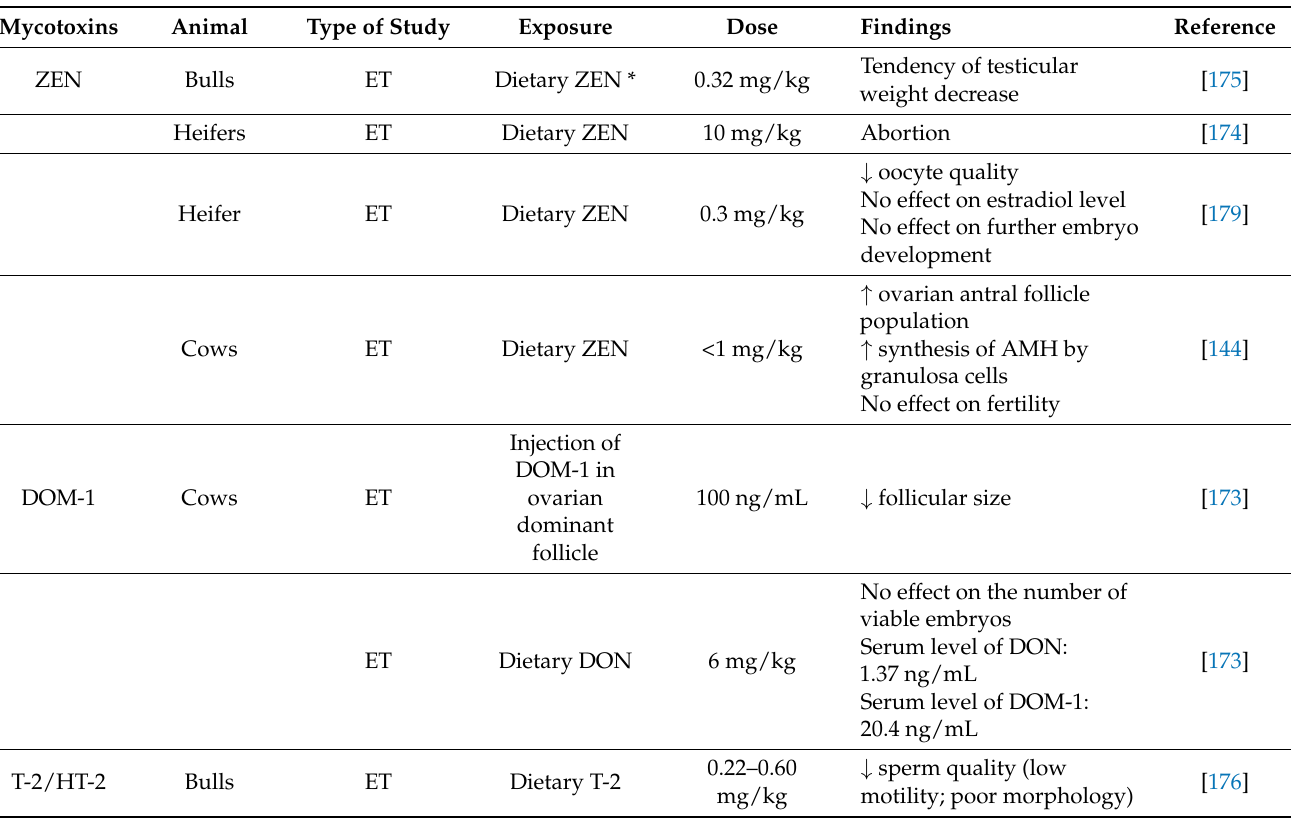
Table 3. Effects of Fusarium toxins on livestock reproductive function ( in vivo studies in